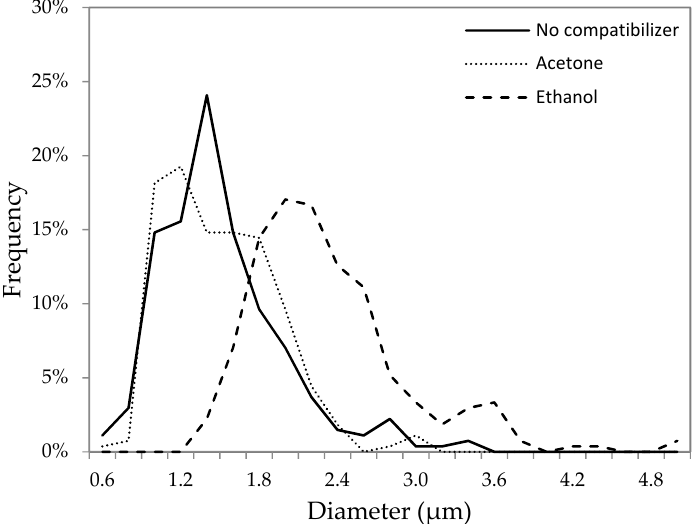
Figure 5. Size distribution of aqueous droplets in emulsion one with the poly(2,6-dimethyl-1,4- phenylene oxide) (PPO) solution in TCE as a continuous phase in the presence of different compatabilizers.